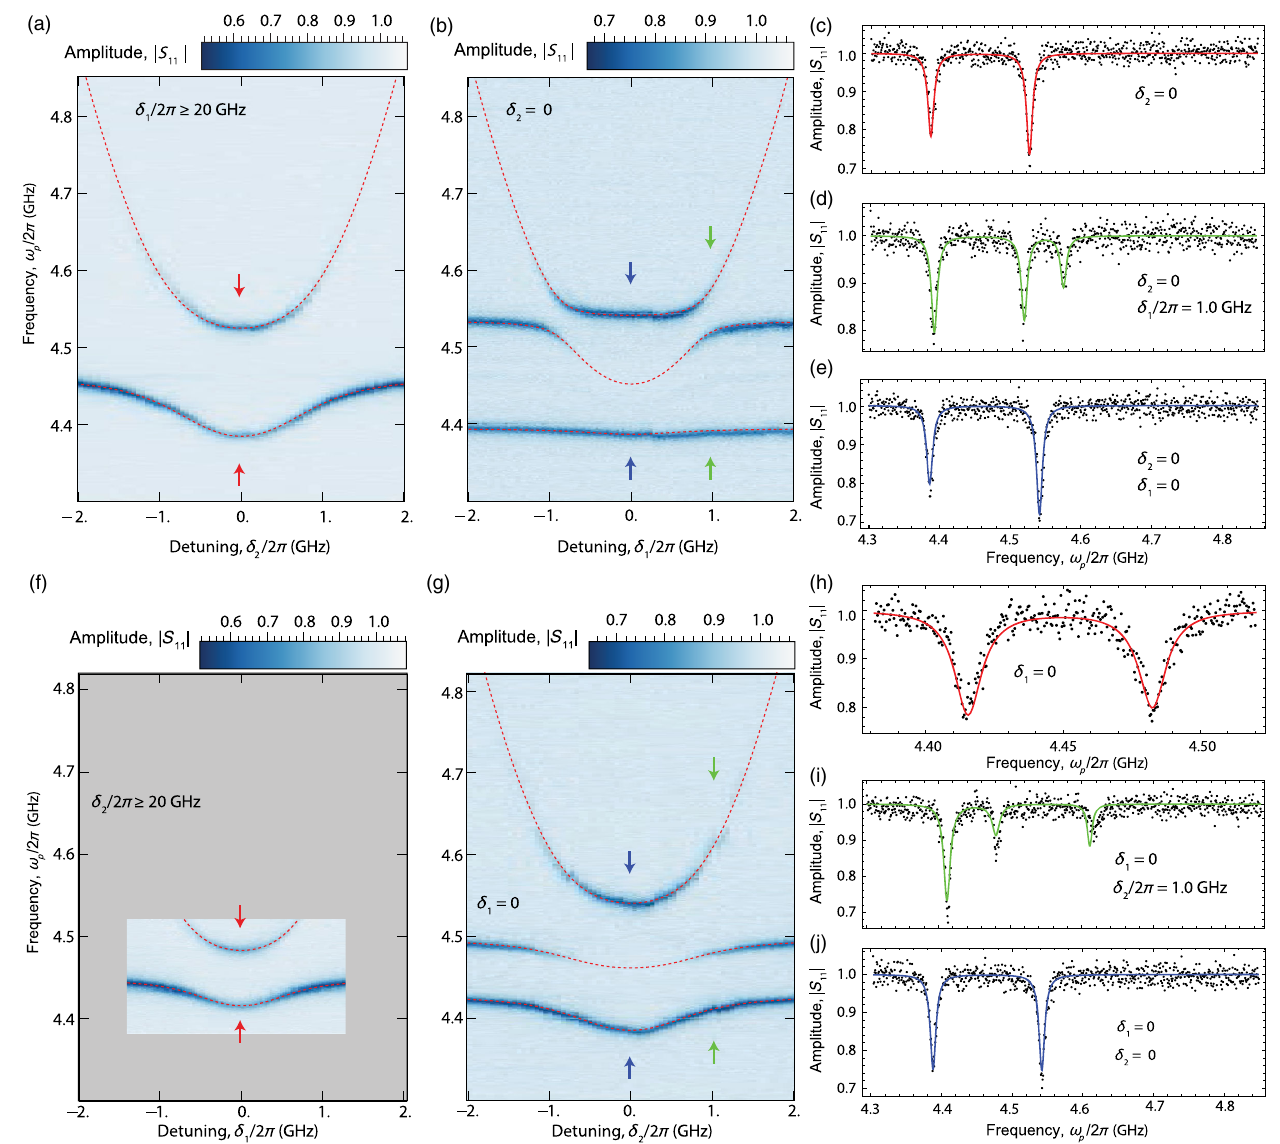
FIG. 8. Resonator spectroscopy with one or two qubits tuned into resonancewith the resonator. Similar to the data in Fig.2 except that the device is biased at a point with coupling rates g 1 = 2 π ¼ 34 MHz and g 2 = 2 π ¼ 69 MHz. Alldata are fitted with master-equation simulations (Appendixes C and H). (a) Measuring the reflection spectrum j S 11 j while tuning δ 2 of DQD 2 ( 2 t 2 = 2 π ¼ 4 . 448 GHz) and DQD 1 is in = 2 π ¼ 4 . 462 GHz. (b) Reflection spectrum j S 11 j , when resonator Coulomb blockade δ 1 = 2 π ≳ 20 GHz. The resonator is flux tuned to ω r DQD 2 are in resonance ( δ 2 ¼ 0 ), the detuning δ 1 of the weaker coupled DQD 1 ( 2 t 1 = 2 π ¼ 4 . 452 GHz) is swept. (c) Line trace of reflection spectrum j S 11 j in (a) at the red arrows showing two separate resonances. (d) Resonator spectroscopy line trace obtained from (b) when ω 0 obtaining ω ω ω g 2 ≈ ω (green arrows). (e) Resonator spectroscopy line trace adopted from (b) at δ 1 ; 2 ¼ r ¼ DQD 2 þ DQD 1 DQD 1 ¼ DQD 2 (blue arrows). (f) Reflection spectrum j S 11 j , while tuning δ 1 of DQD 1 ( 2 t 1 = 2 π ¼ 4 . 450 GHz), when DQD 2 is in Coulomb blockade δ 2 π ≳ 20 GHz. (g) Keeping DQD 2 t 2 π ¼ 4 . 461 GHz) is tuned vs δ 2 = 1 resonator in resonance, DQD 2 ( 2 = 2 , resulting in hybridization in the ω ω casewhere all three systems are in resonance, ω . (h) Line trace of (f) (red arrows) showing the reflection spectrum j S 11 j r ¼ DQD 2 ¼ DQD 1 g 1 ≈ ω with two resonances. (i) Line trace of (g) (green arrows) taken at ω , showing the DQD 2 tuned into resonance with the DQD 1 þ DQD 2 0 , line trace of the j S hybridized DQD 1 resonator state, jþi . (j) Data taken at the similar configuration as (e), δ 1 11 j in (g) (blue ; 2 ¼ r 3